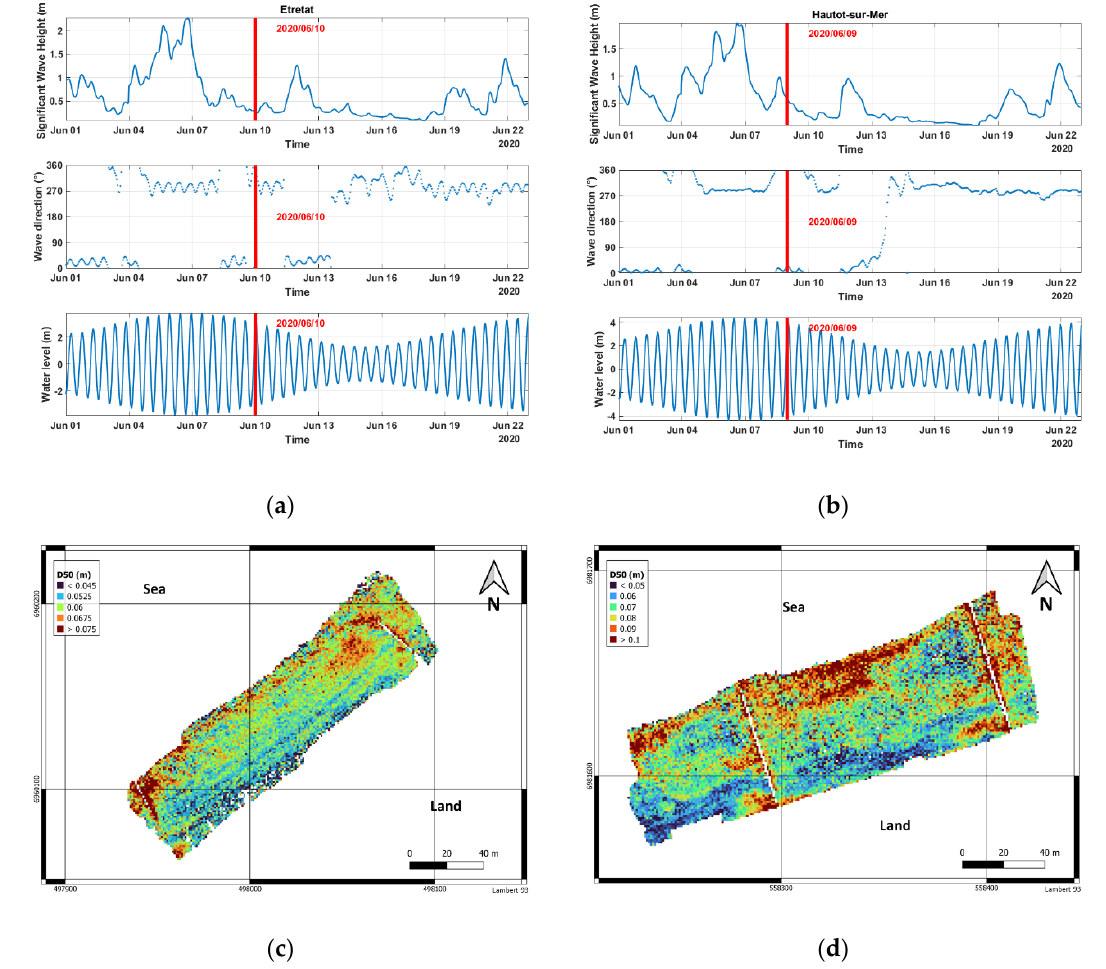
Figure 13. Hydrodynamic conditions at ( a ) Etretat and ( b ) Hautot-sur-Mer preceding the UAV campaigns. Significant wave height (top), wave direction (center) and water level (bottom).